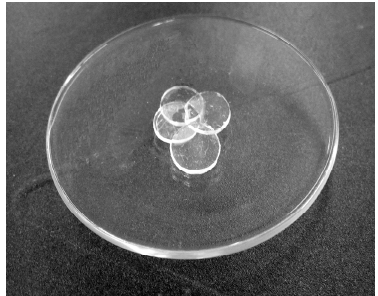
Figure 7. Dried discs of 3 .